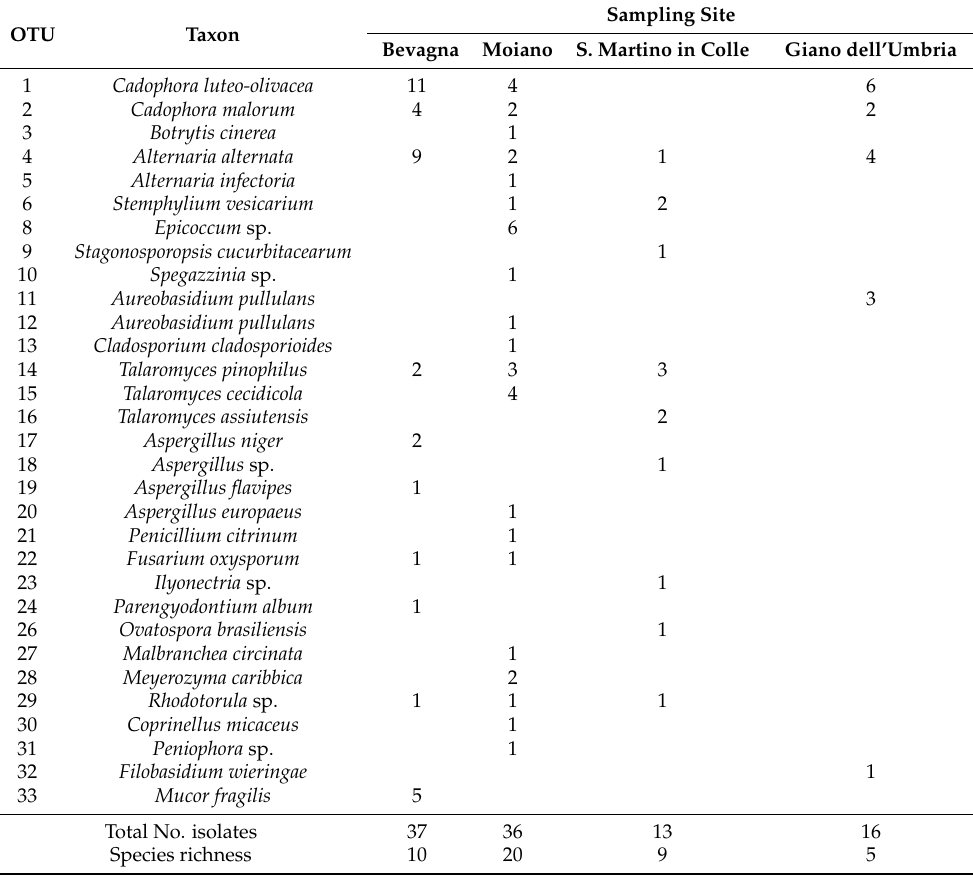
Table 5. Diversity of fungal endophytes in C. sativus at different cultivation